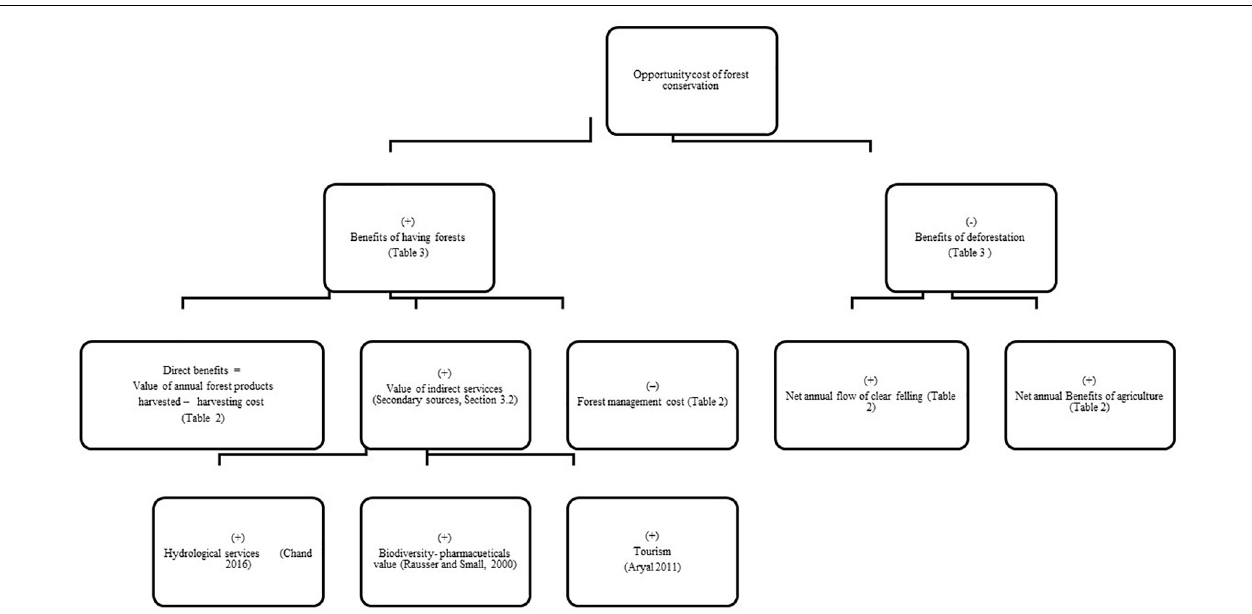
FIGURE 2 | Analytical framework of estimating benefits and costs of reducing